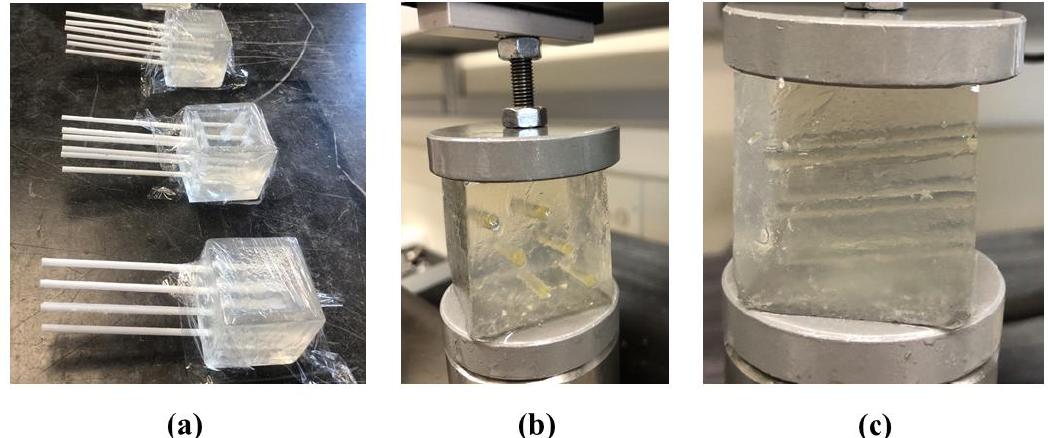
Figure 3. ( a ) Samples of gelatin-based phantoms each including six channel-in-phantoms (CIPs) made by sealed straws which are removed when the gelatin mixture hardens to produce channels. ( b ) and ( c ) show the front and side views of one of the samples from ( a ), respectively undergoing the stress relaxation test after injecting castor oil inside the CIPs.